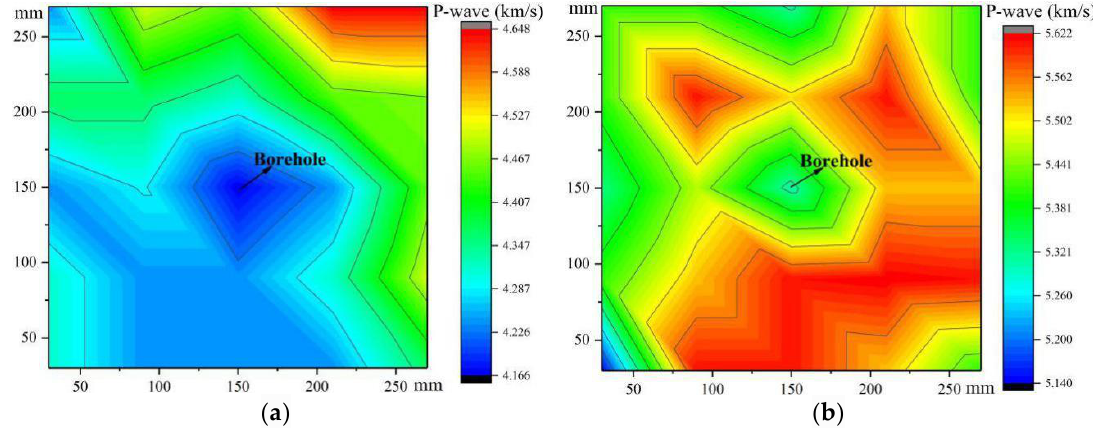
Figure 5. The P-wave velocity distributions of the ( a ) granodiorite and ( b ) monzogranite.